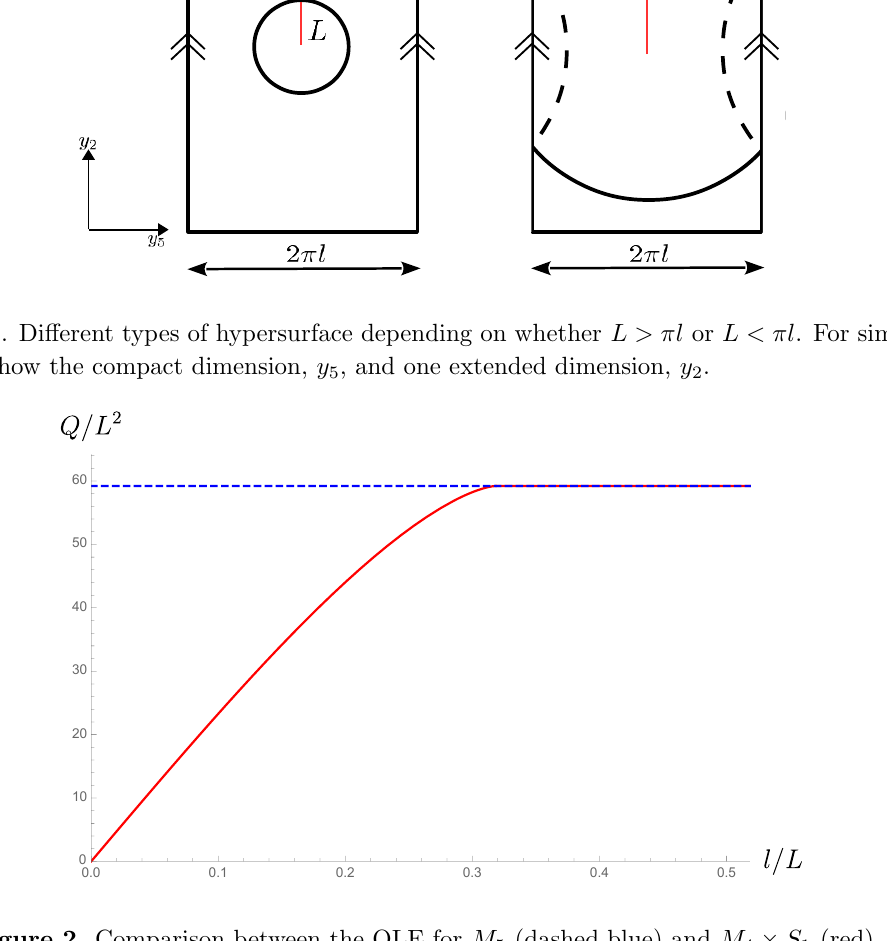
Figure 2 . Comparison between the QLE for M 5 (dashed blue) and M 4 (cid:2) S 1